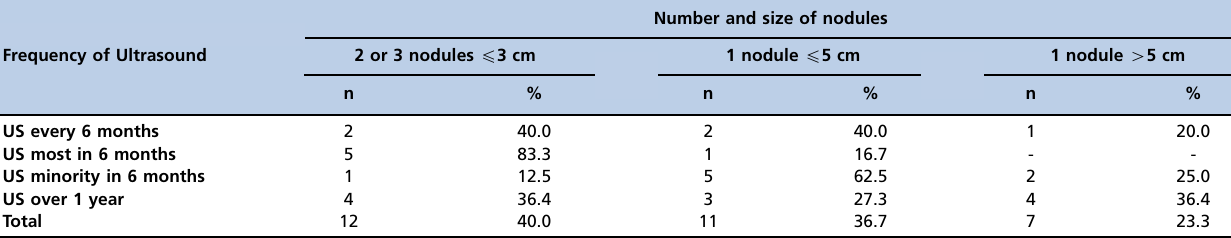
Number and size of nodules